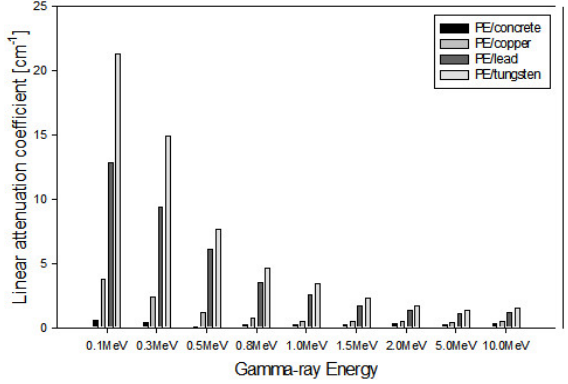
Figure 11. Linear attenuation coefficient of fibrous composite; fiber diameter 0.0798 cm.